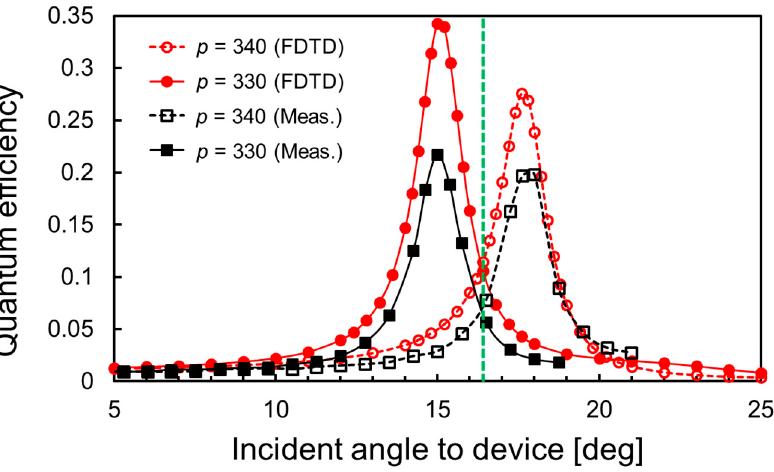
Figure 12. Simulated and measured quantum efficiencies (QEs) with respect to incident angle to device surface.